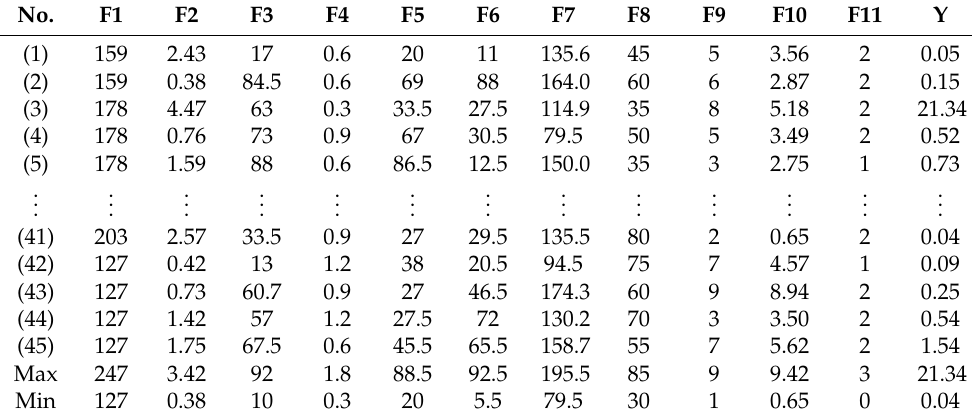
Table 5. Engineering